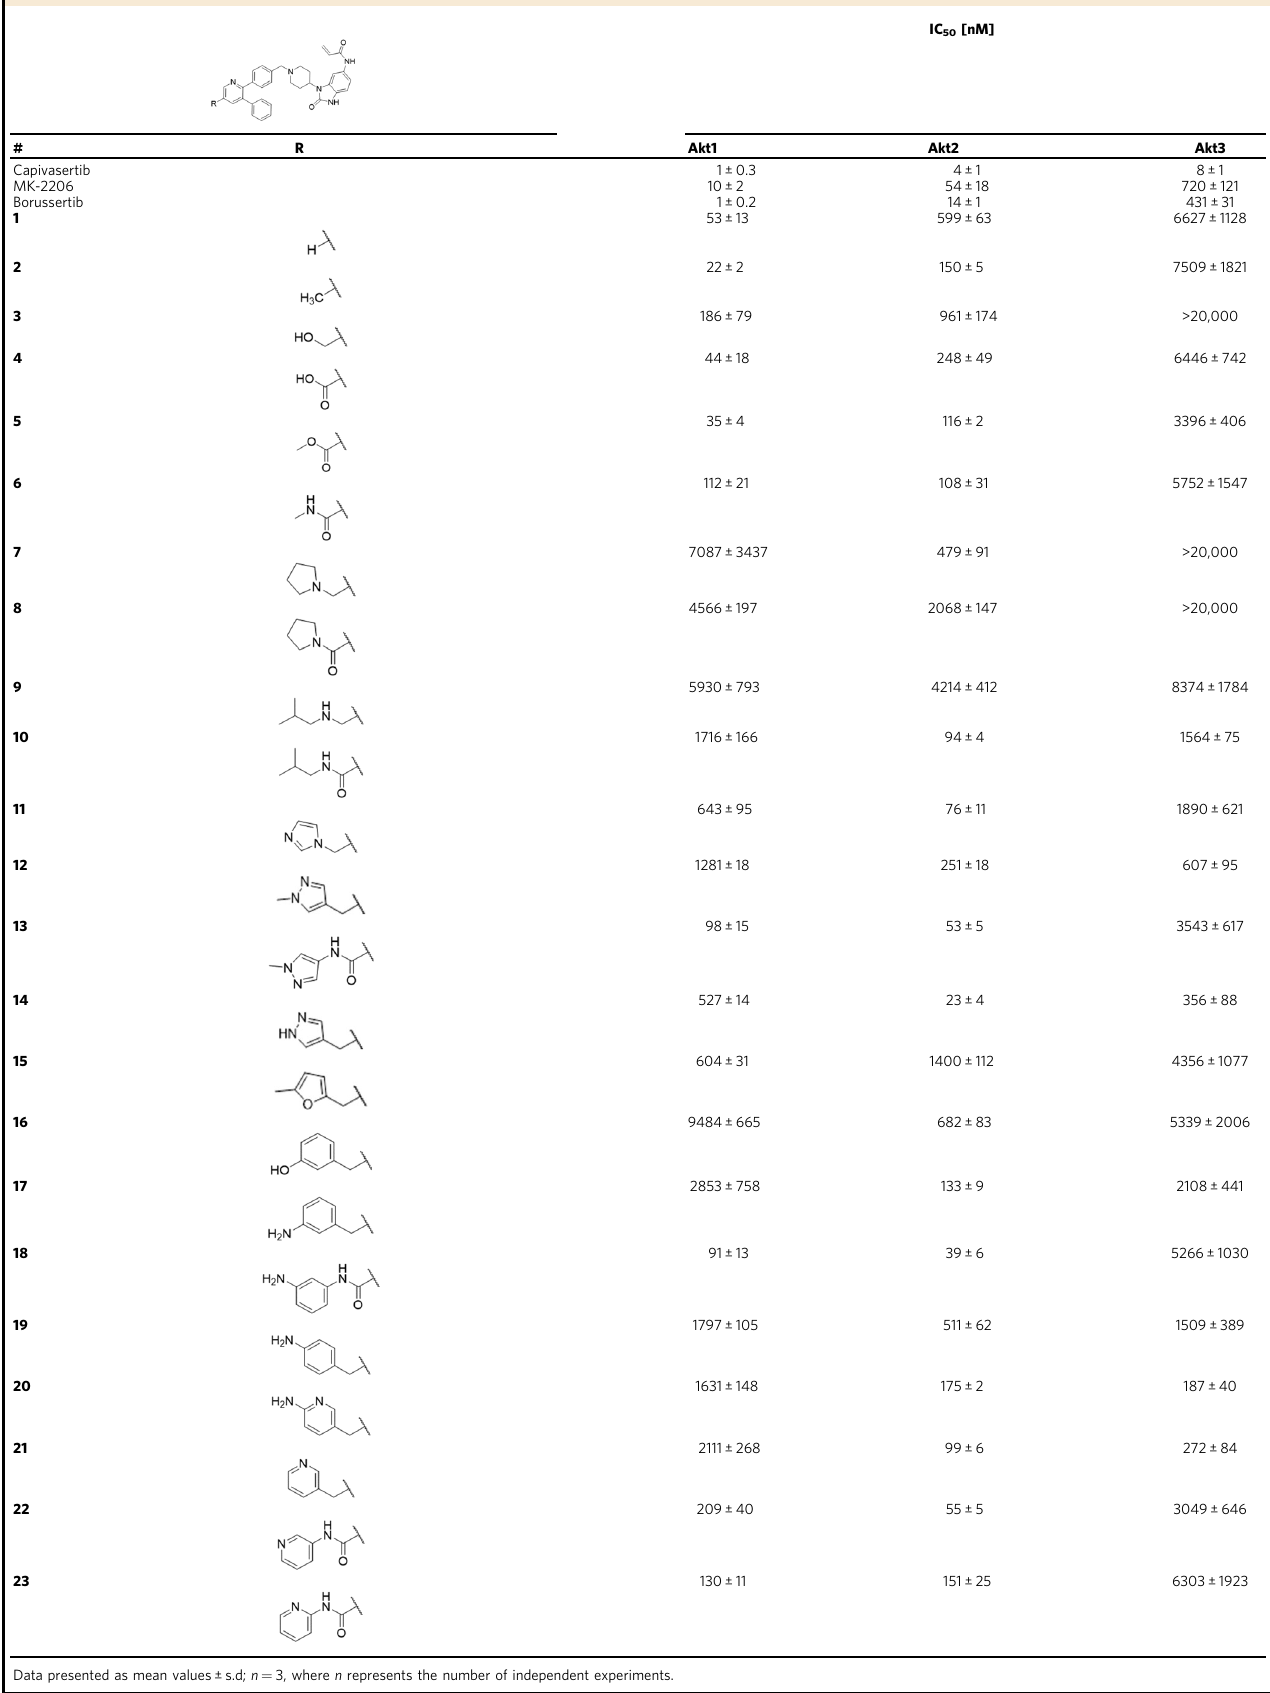
Table 1 Biochemical evaluation of covalent-allosteric Akt inhibitors with the Akt